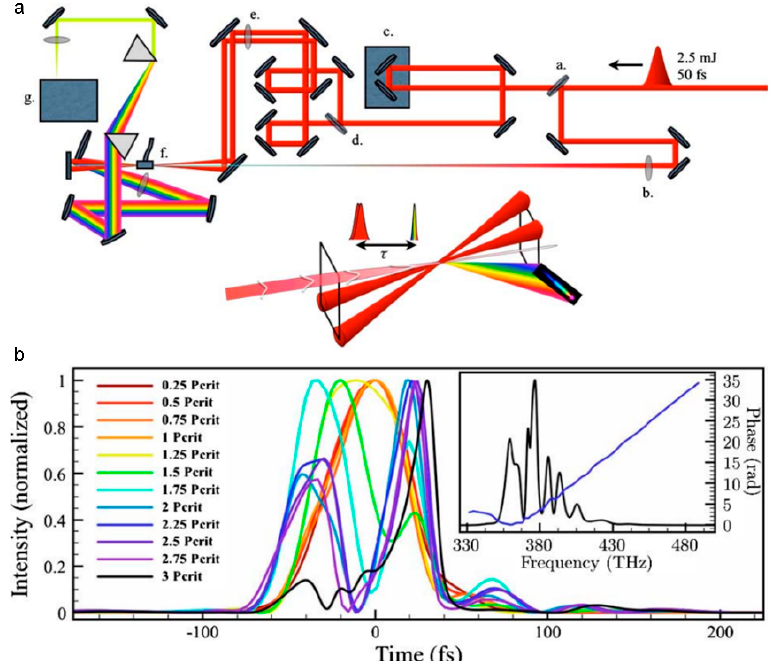
Figure 7. Sensing of laser pulse in filament. ( a ) Experimental arrangement and ( b ) filament temporal profiles for the TG-FROG measurements of filaments under different laser power. a. 80/20 beam splitter; b. f = 2.07 m lens; c. delay stage; d. 50/50 beam splitter; e. f = 0.5 m lens; f. argon jet; g. USB spectrometer. Pcrit: critical power for self-focusing [141].